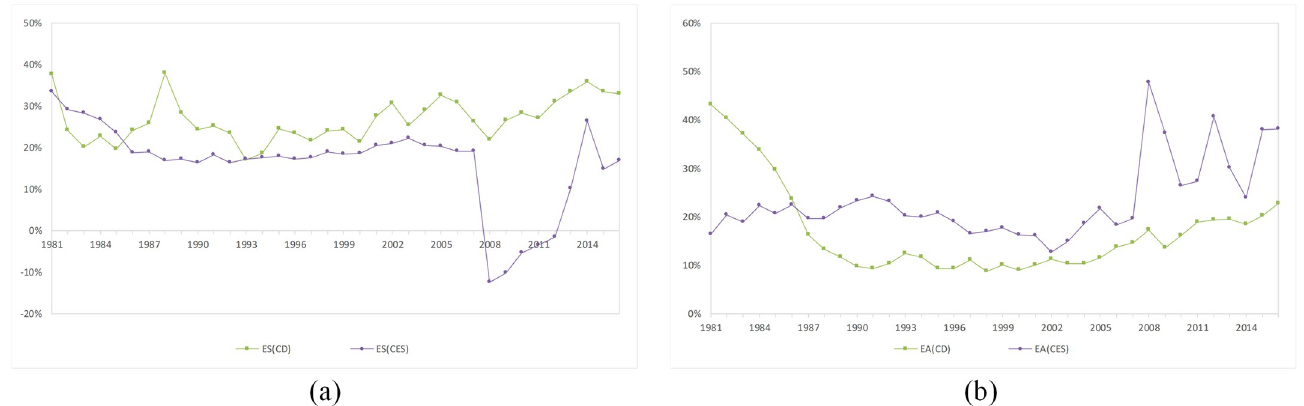
Fig 5. Comparison of the scale economy contribution rates and Solow residual